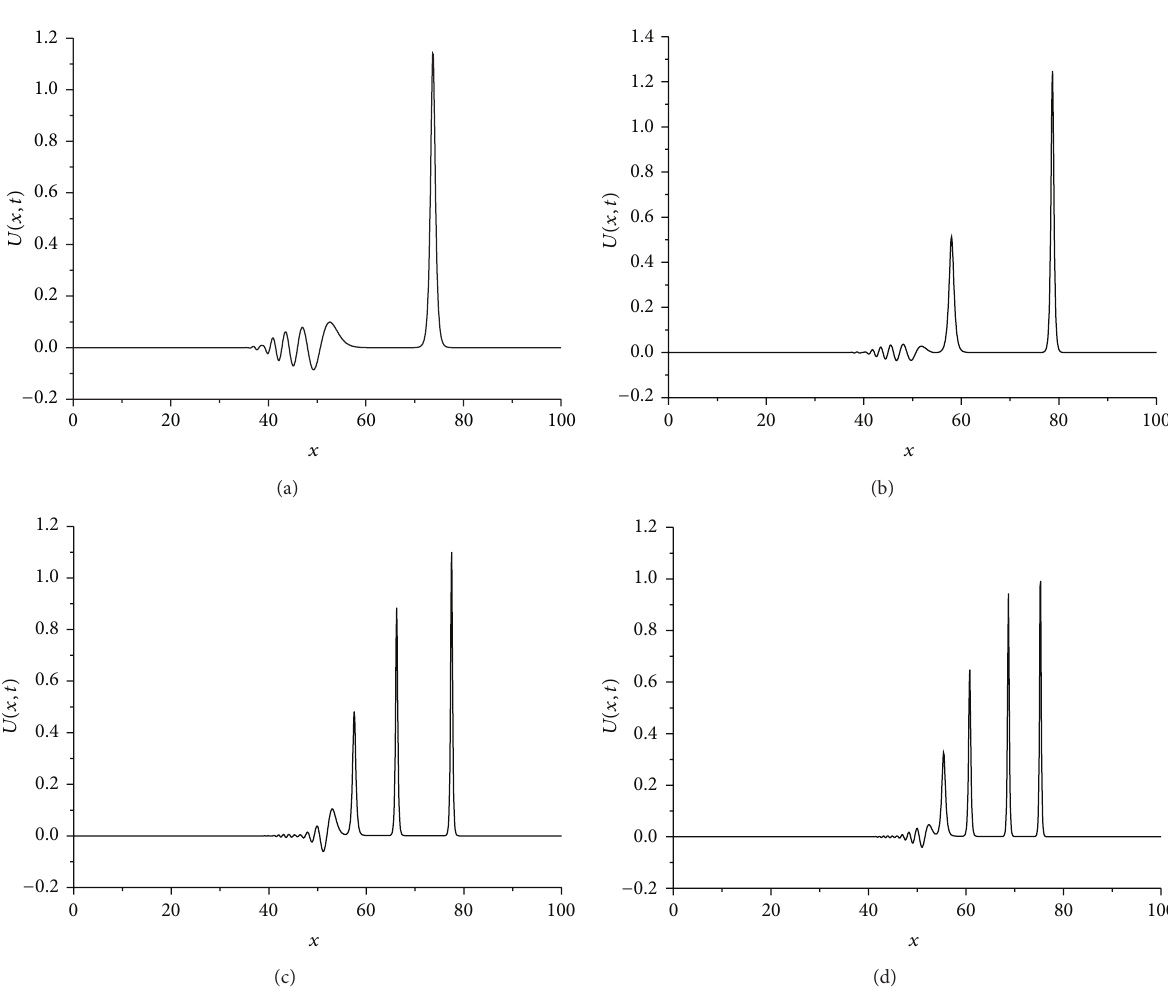
Figure 6: Maxwellian initial condition at 𝑡 = 14.5 with (a) 𝜇 = 0.1 , (b) 𝜇 = 0.015 , (c) 𝜇 = 0.01 , and (d) 𝜇 = 0.04